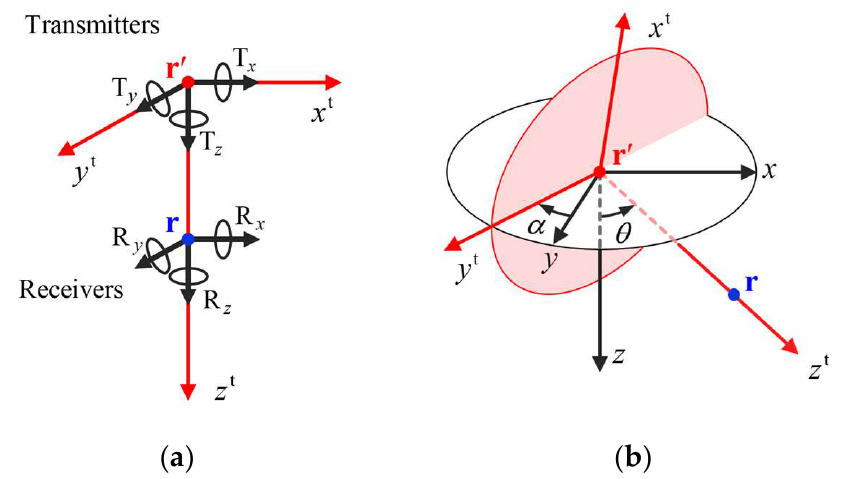
Figure 7. Triaxial logging tool and its orientation. ( a ) Structure of the tool in the tool coordinates x t y t z t . ( b ) Orientation of the tool coordinates x t y t z t with respect to the formation coordinates xyz , where α and θ are the tool azimuthal and dip angles, respectively.